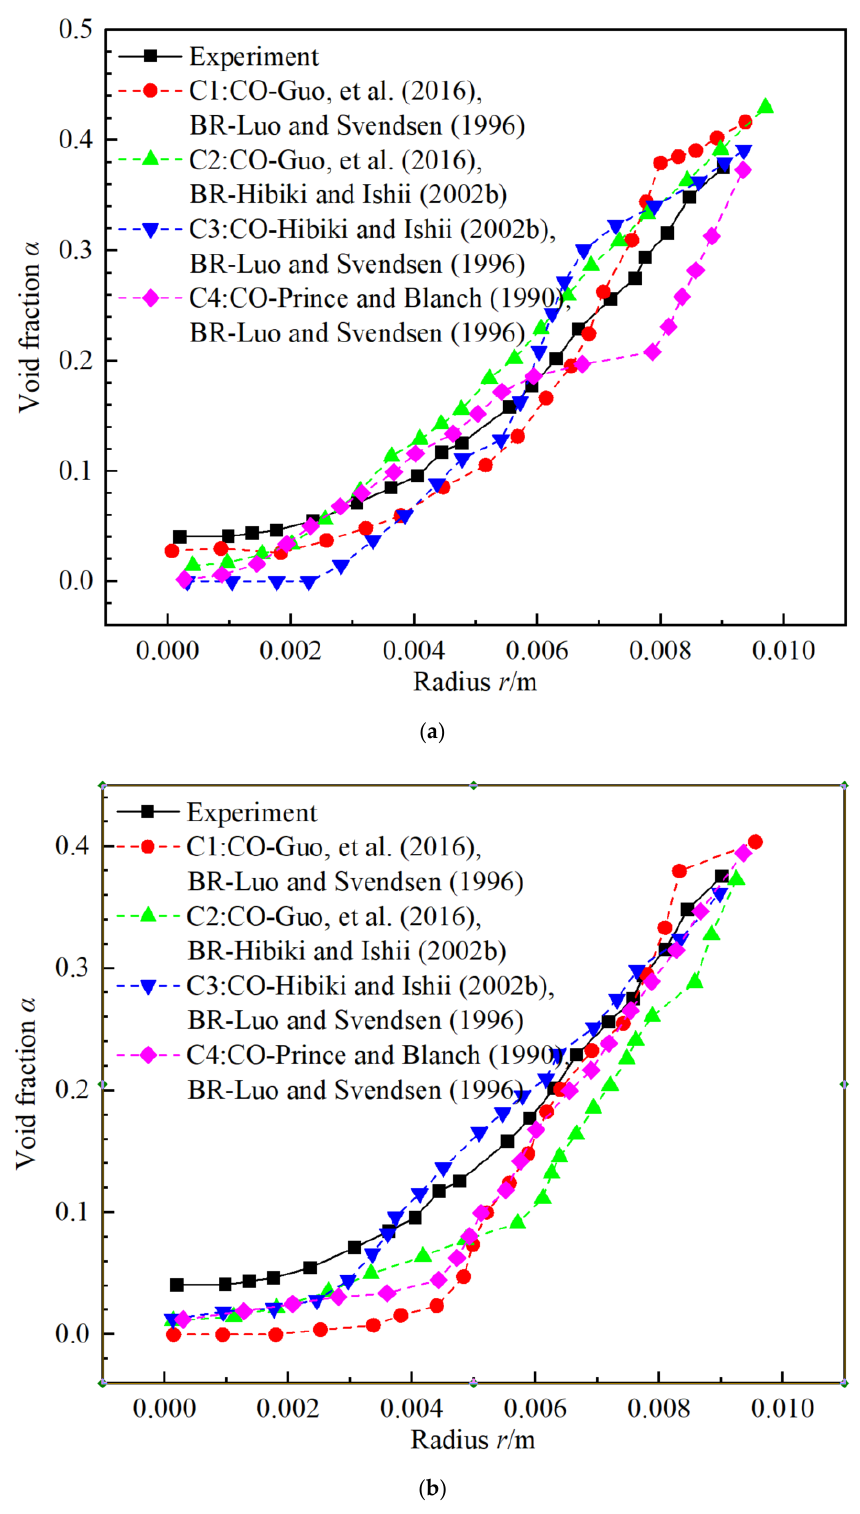
Figure 6. Void fraction α distribution of various combinations of coalescence and breakup kernel with model of D d [8], f [46] and DEBORA-1 experiment ( P = 2.62 MPa) [28] at z = 3.5 m. ( a ) with Nn of Kocamustafaogullari and Ishii [36], ( b ) with N n of Basu [40]. In Figure 6a, the maximum relative errors between four combinations of C1, C2, C3 and C4 under the N n model of Kocamustafaogullari and Ishii [36] with the DEBORA-1